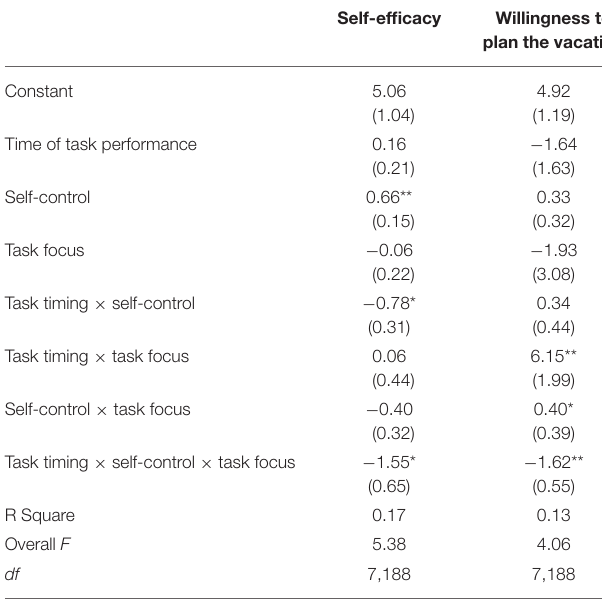
TABLE 3 | Experiment 3. TABLE 4 | Self-efficacy and willingness to plan a vacation, as a function of self-control, task timing, and task focus (Experiment 3).